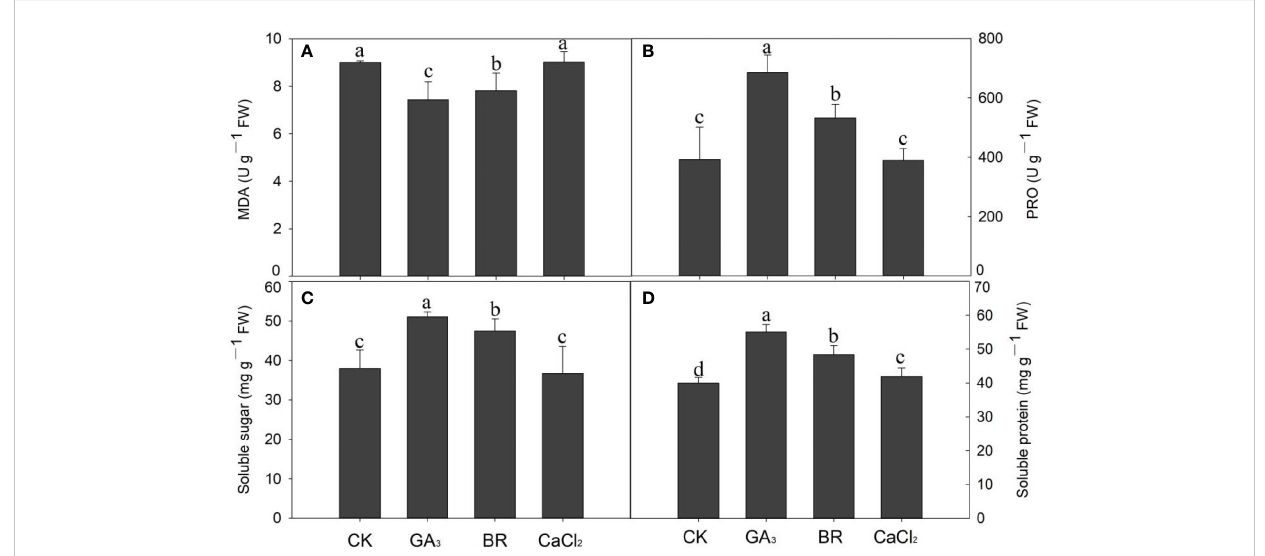
FIGURE 5 Response of (A) MDA, (B) proline, (C) soluble sugar, and (D) soluble protein content to various seed priming treatments under chilling stress. Different lowercase letters indicate signi fi cant differences (P< 0.05) among the treatments. Bar shows standard